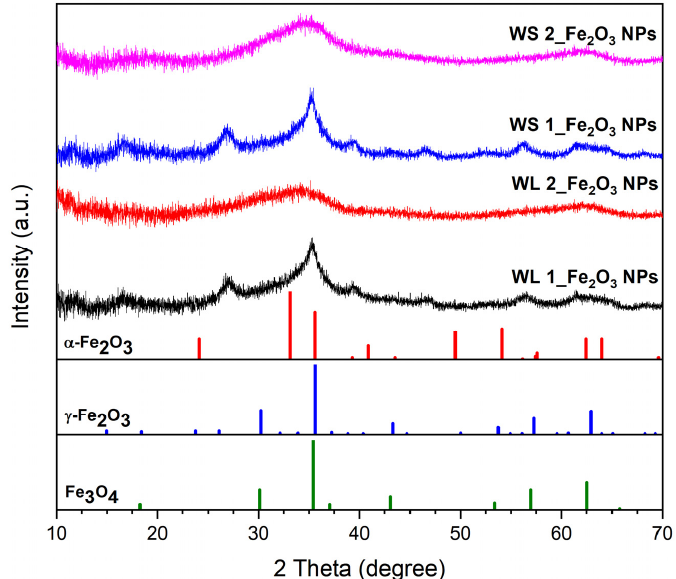
Figure 2. XRD patterns of IONPs obtained from wormwood leaves and stems aqueous extracts versus XRD patterns of hematite– α -Fe 2 O 3 (red, PDF file: 330664), maghemite– γ -Fe 2 O 3 (blue, PDF file: 391346), and magnetite–Fe 3 O 4 (green, PDF file: 190629) from (ICDD PDF) 4+ 2019 data.